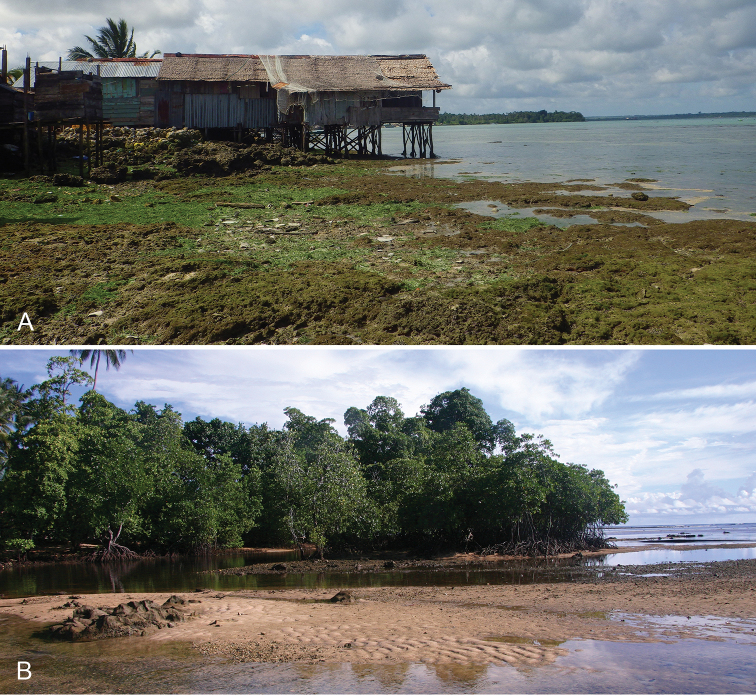
Habitats, Peronia
griffithsiA Indonesia, Kei Islands, rocks behind muddy Rhizophora mangrove (st 144) B Papua New Guinea, New Ireland, mixed hard platform and seagrass bed at outlet of rivulet (st KM 05).